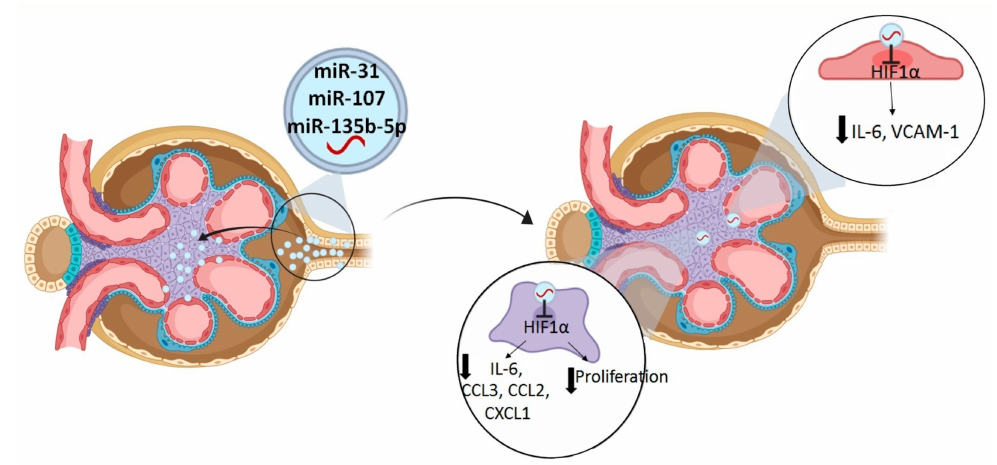
Figure 8. Proposed mechanism for urinary exosomal miRNAs in lupus nephritis renal recovery. Urinary exosomes from LN responder patients with high levels of miR-31-5p, miR-107, and miR-135b-5p are produced mainly in tubular renal cells to be engulfed by endothelial and mesangial renal cells. MiRNAs target HIF1A in endothelial renal cells, reducing the production of IL6 and VCAM-1 . In mesangial renal cells, miRNAs target HIF1A , inhibiting mesangial renal cell proliferation and downregulating the production of CXCL1, CCL3, CCL2, and IL6